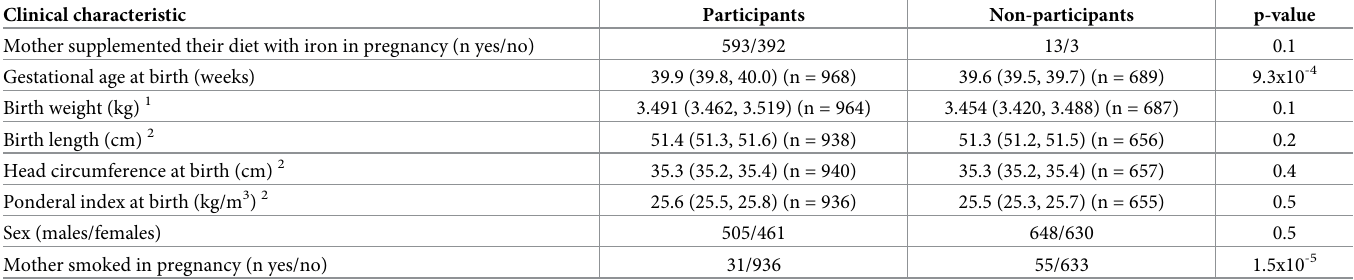
Table 1. Characteristics of those participants (of the infancy growth studies) in this analysis and those participants from the Cambridge Baby Growth Study who did not participate in this